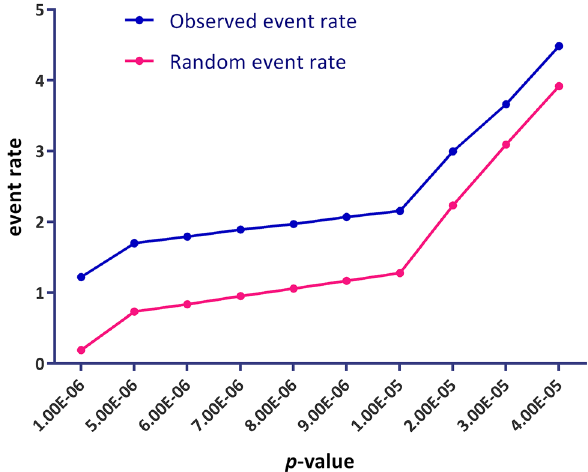
Figure 1. A survey of accuracy of fastLA analysis. In the wide range of the significant fastLA p -values, the observed event rate of X 3 position (switch) genes was compared with the random event rate. The random event rate is equal to the ratio of the number of statistically significant triplets (in a particular p-value) to the number of total examination genes; the observed event rate is equal to the ratio of . of significant triplets statistically significant triplets to the number of unique X3. Random event rate = num num . of totalsexaminedgenes ; . of significant triplets Observed event rate = num num . of uniqueX